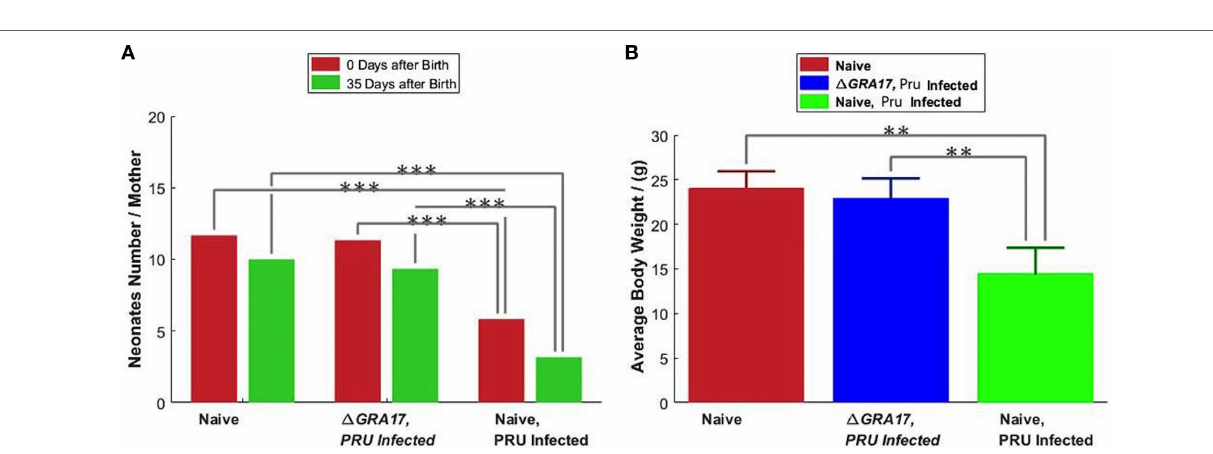
FigUre 10 | Protection of mice against type II Pru cysts infection on day 12 of gestation. (a) The litter size of pups from the non-immunized and uninfected mice (naïve), non-immunized and Pru-infected mice, and immunized and Pru-infected mice was assessed at birth and 35 days after birth. (B) The body weighs of 35 days old pups. Data points indicate means ± SD. Significance compared with naïve control mice: ** p < 0.01, *** p < 0.001.